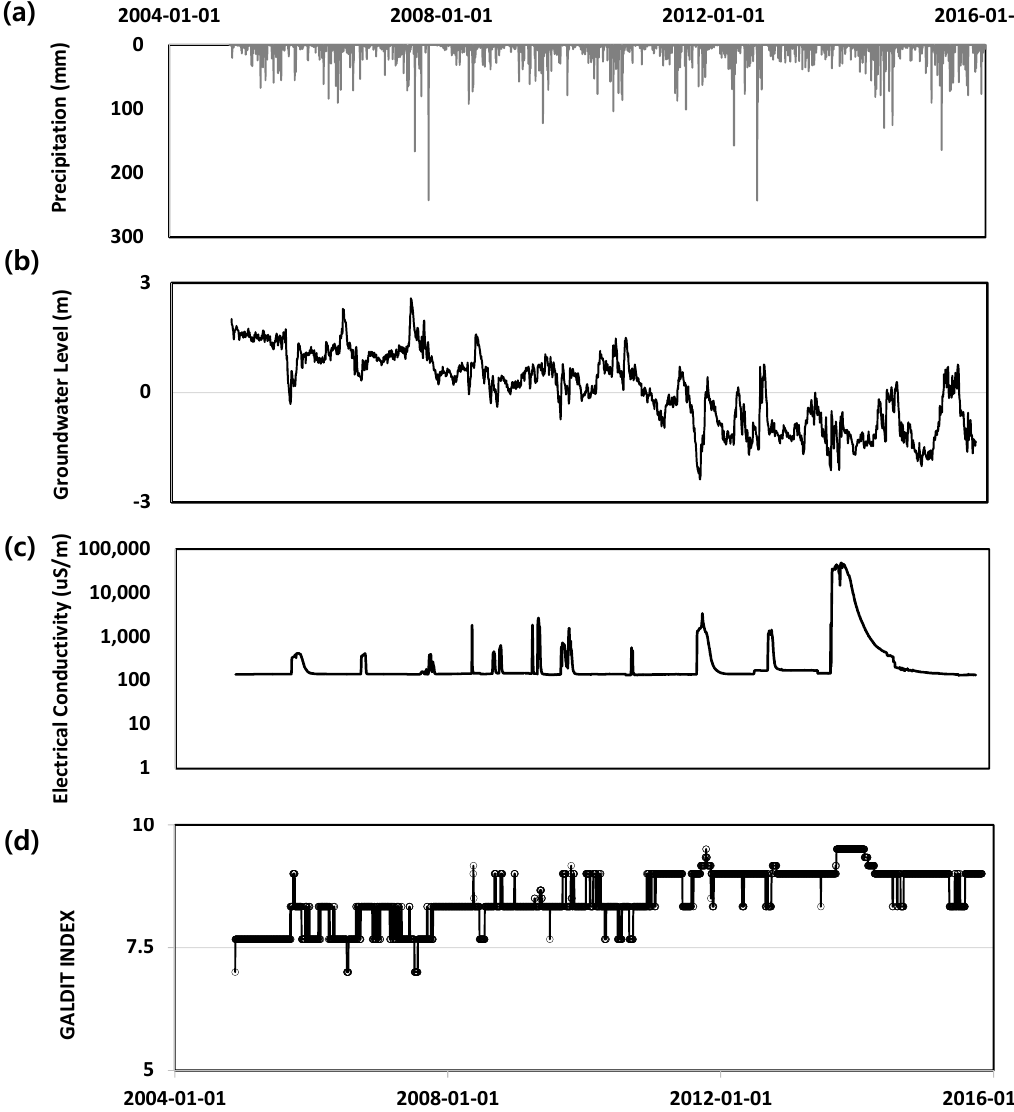
Figure 7. Temporal daily variation of GALDIT in the Mureung area for ( a ) precipitation, ( b ) groundwater level, ( c ) electrical conductivity, and ( d ) GALDIT index.